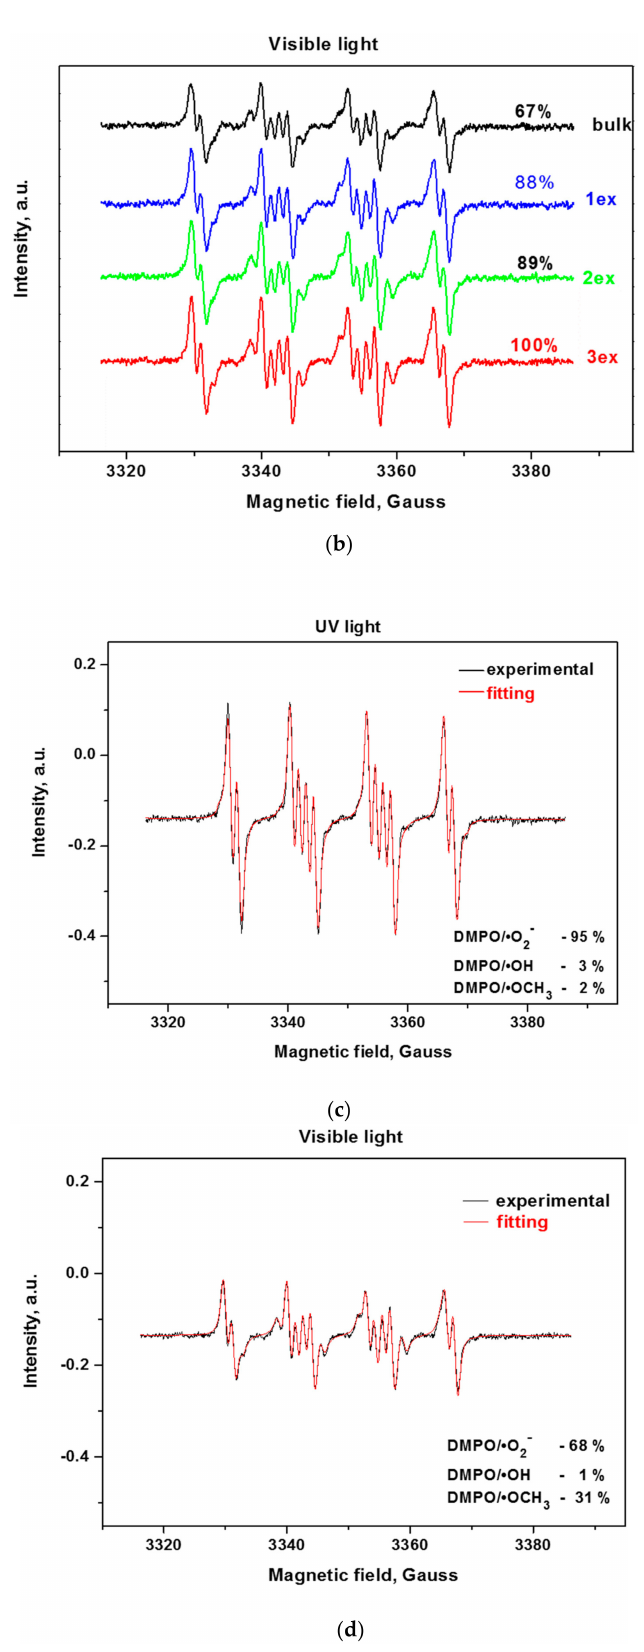
Figure 8. EPR spectra of radical adducts of DMPO under UV ( a ) and visible light ( b ) and simulation of radical adducts for sample 3ex under UV ( c ) and visible light ( d